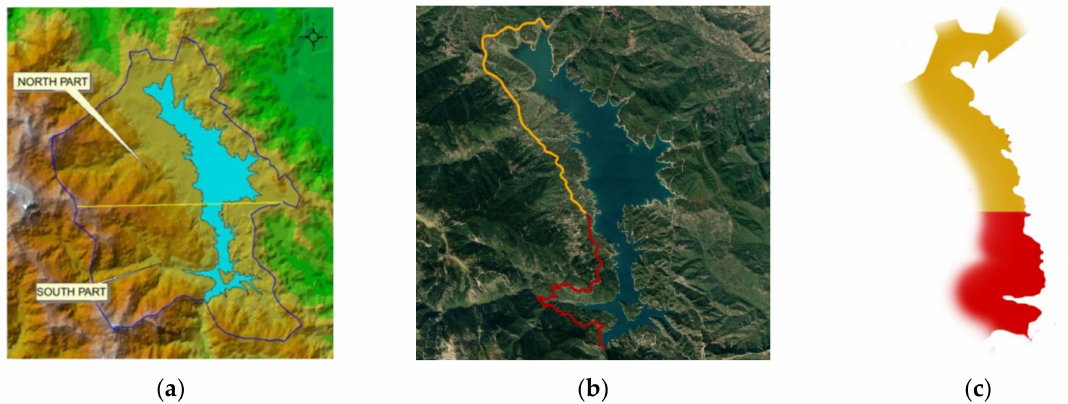
Figure 13. ( a ) Plastiras reservoir; ( b ) Examined sections of road; ( c ) ZTV of the south (red) and north (yellow) parts of the